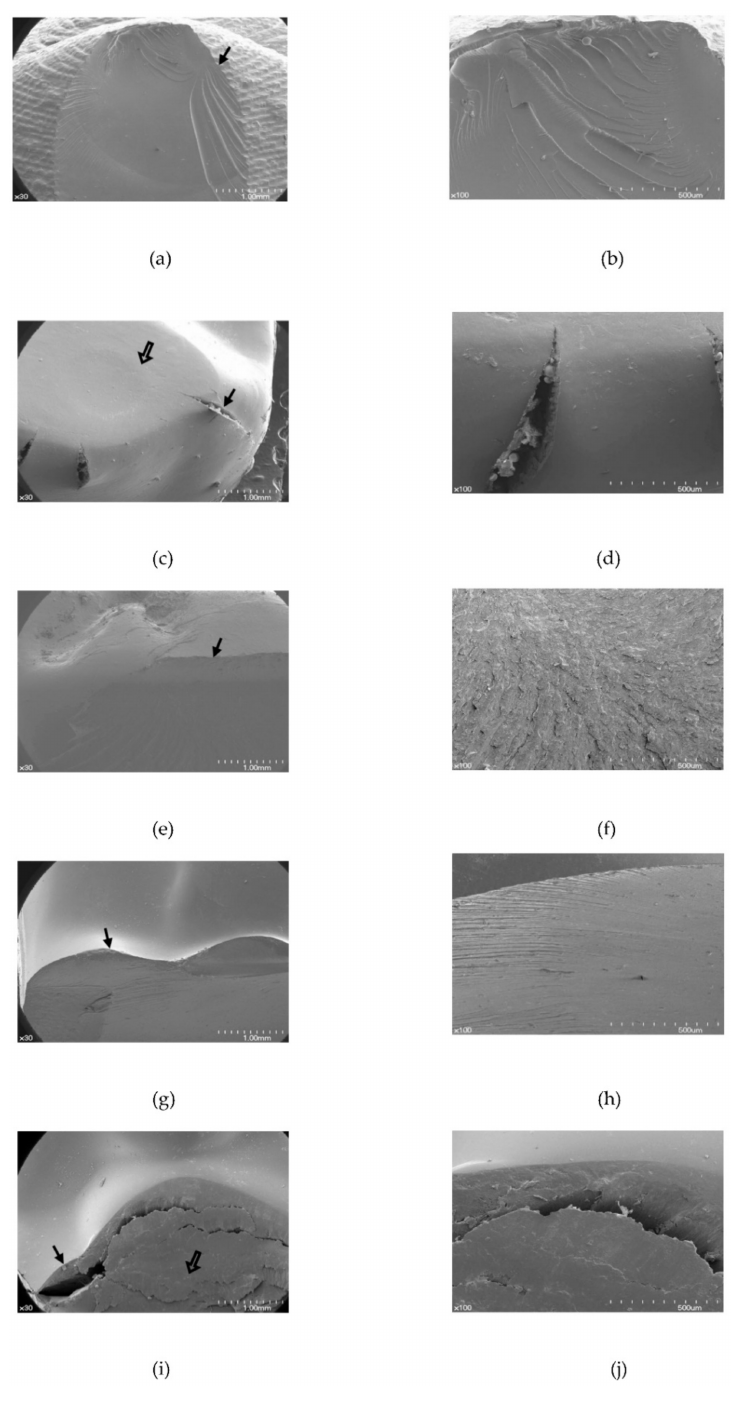
Figure 5. Scanning electron microscopy images after chipping test (occlusal view). ( a ) The 3D printed resin teeth (original magnification × 30); ( b ) the 3D printed resin